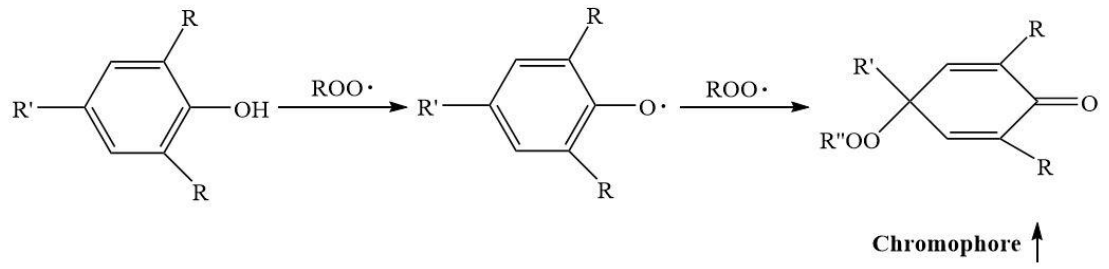
Figure 5. The reaction of phenolic antioxidants to destroy free radicals and the generation of chromogenic groups.